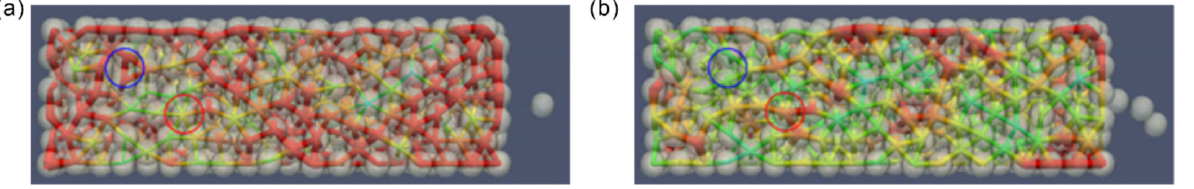
Figure 7. Force chain of the porous media. (( a ) t = 0.05 s; ( b ) t = 0.1 s).